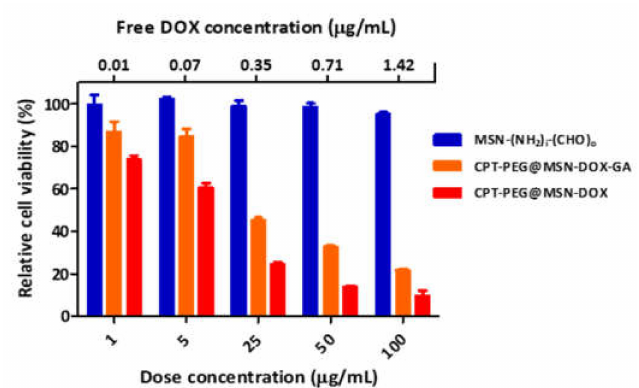
Figure 8. Cell viability of HepG2 cells incubated with MSN-(NH 2 ) i -(CHO) o , CPT-PEG@MSN-DOX-GA , and CPT-PEG@MSN-DOX for 72 h. Data represented as mean ± SD ( n = 3). The concentration of free